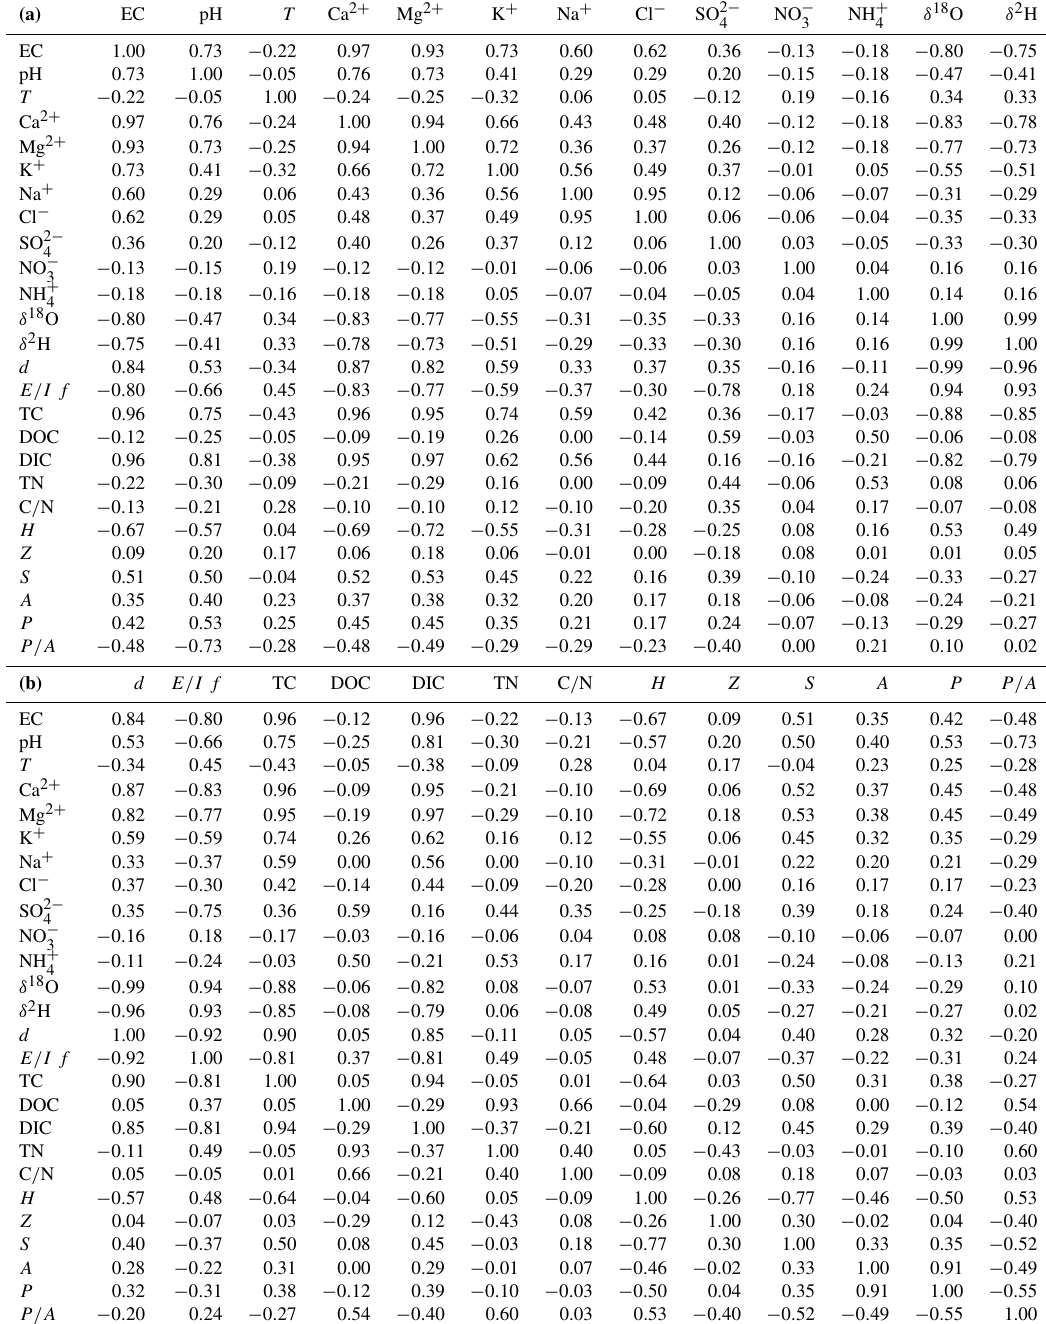
Table A1. Correlation matrix between hydrological tracers and morphometric